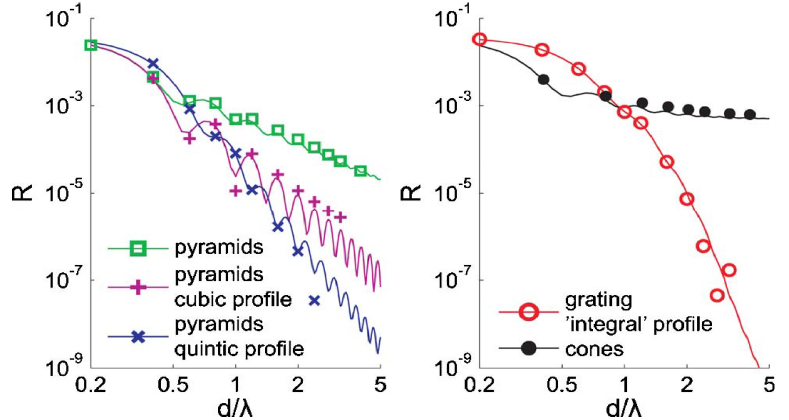
Figure 13. Reflectivity results from graded-index films with an integral RI profile (cid:3053) ( (cid:1858)((cid:1878)) = (cid:1829) (cid:1516) (cid:1857) (cid:3085) (cid:3127)(cid:3117) ((cid:3031)(cid:2879)(cid:3085)) (cid:3127)(cid:3117) (cid:1856)(cid:2014) ), square pyramids with linear and quantic RI profiles closely (cid:2868) packed in a square lattice, and cones closely packed in a triangular lattice from EMT (lines) and FDTD (points) calculations. Reprinted with permission from reference [32], Copyright 2011 Optical Society of America.